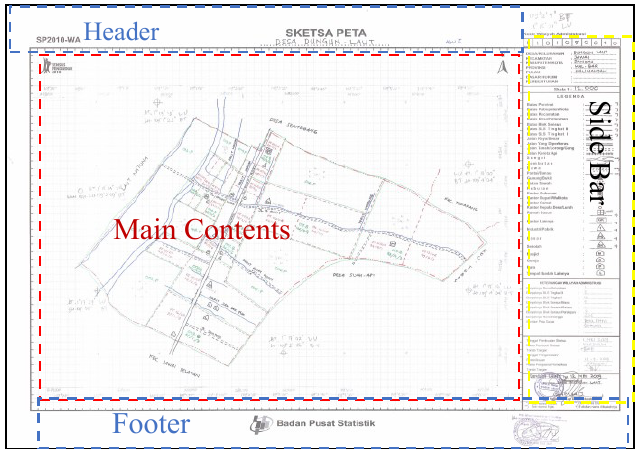
Fig. 3. One of village sketch maps of population census